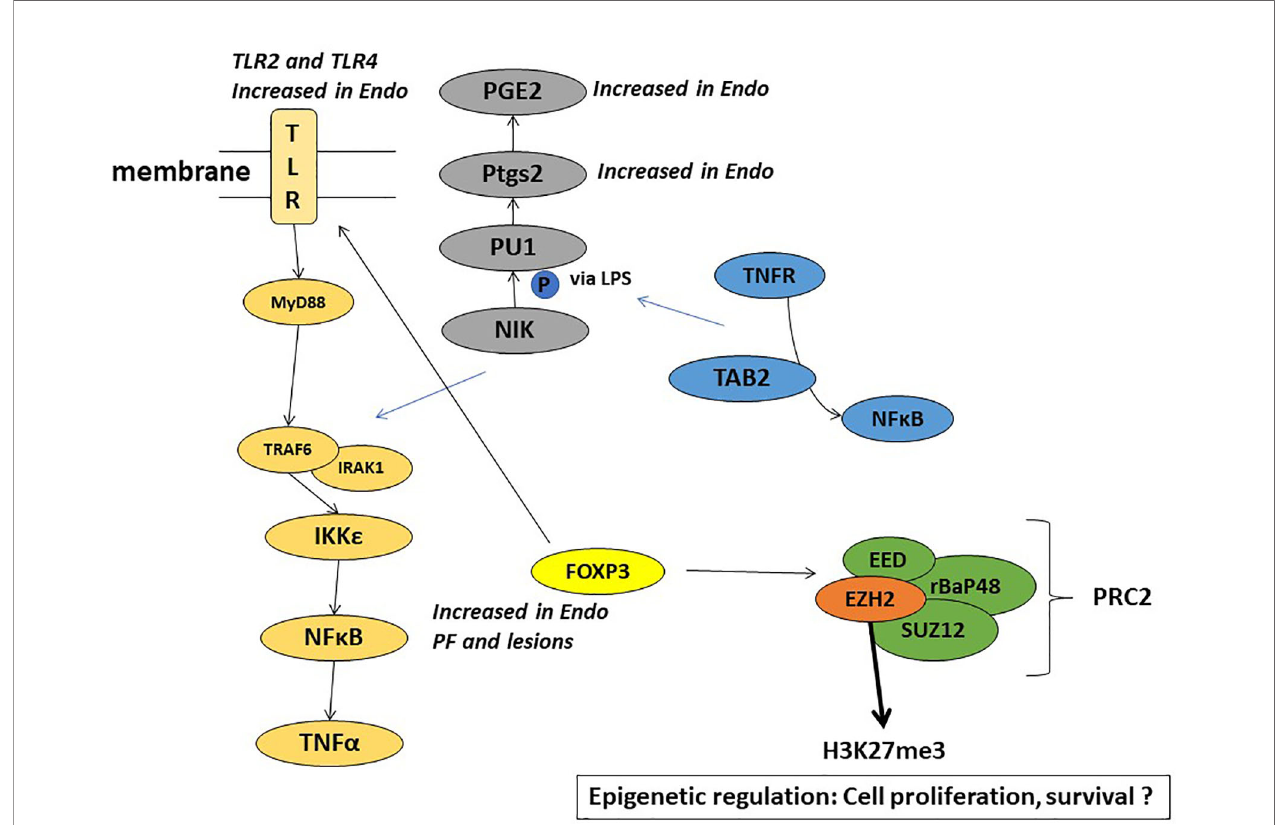
FIGURE 4 | Schematic representation of the plausible mechanisms involved in the role of endometriotic PF in